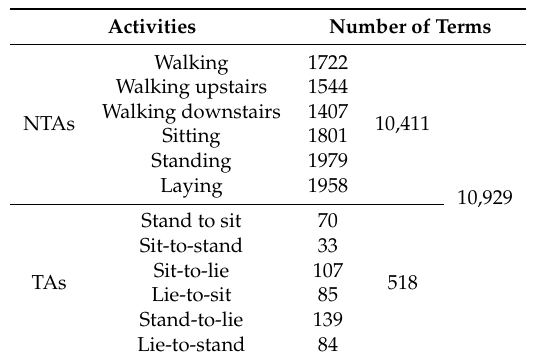
Table 1. Distribution of dataset items for each activity of the Smartphone-based HAR Dataset with Postural Transitions (SBHAR) dataset